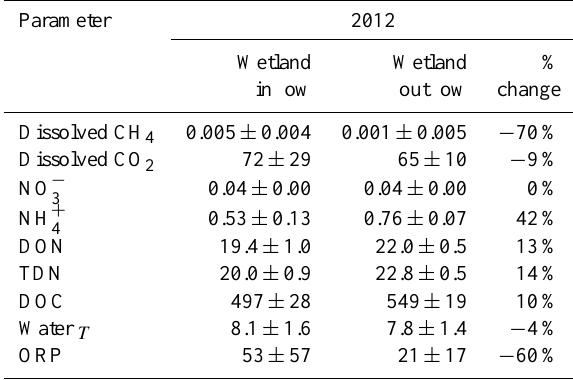
Table 2. Flow-weighted mean concentrations ( ± 1weighted SD) of several chemicals in Skeleton Creek water upstream and down- stream of the wetland during the 2012 growing season. All chem- icals are reported in µmolL − 1 except for water temperature ( ◦ C) and oxidation-reduction potential (mV). Parameter 2012 Wetland Wetland